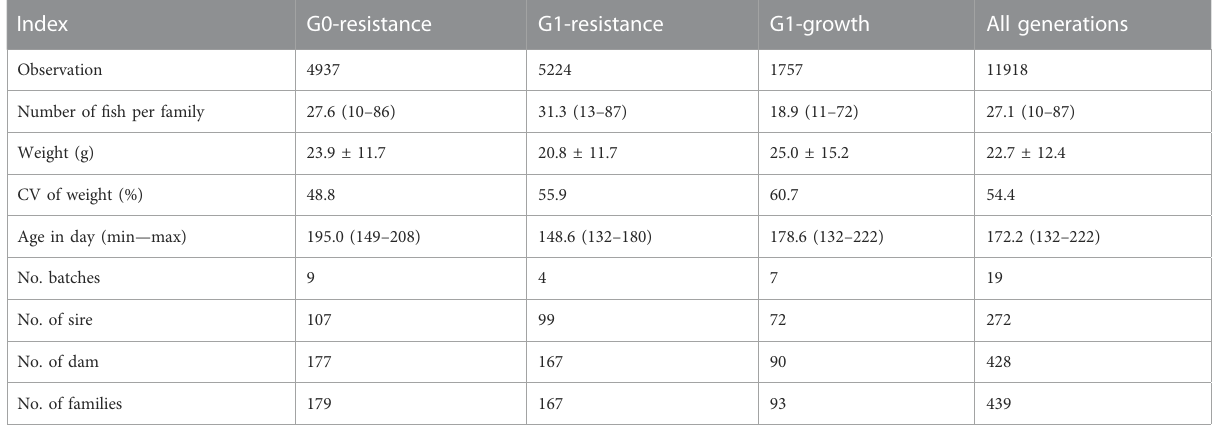
TABLE 1 Descriptive statistics for tagging weight of striped cat fi sh data over 2